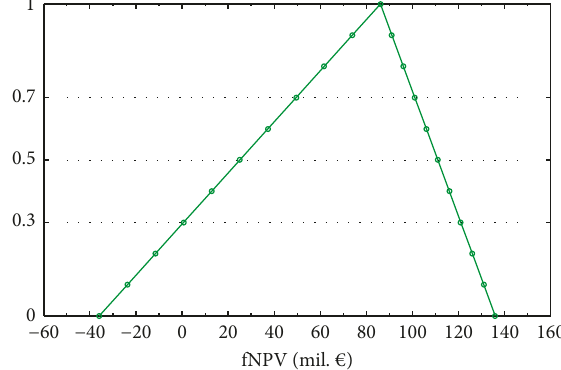
Figure 4: fNPV for a discount rate of